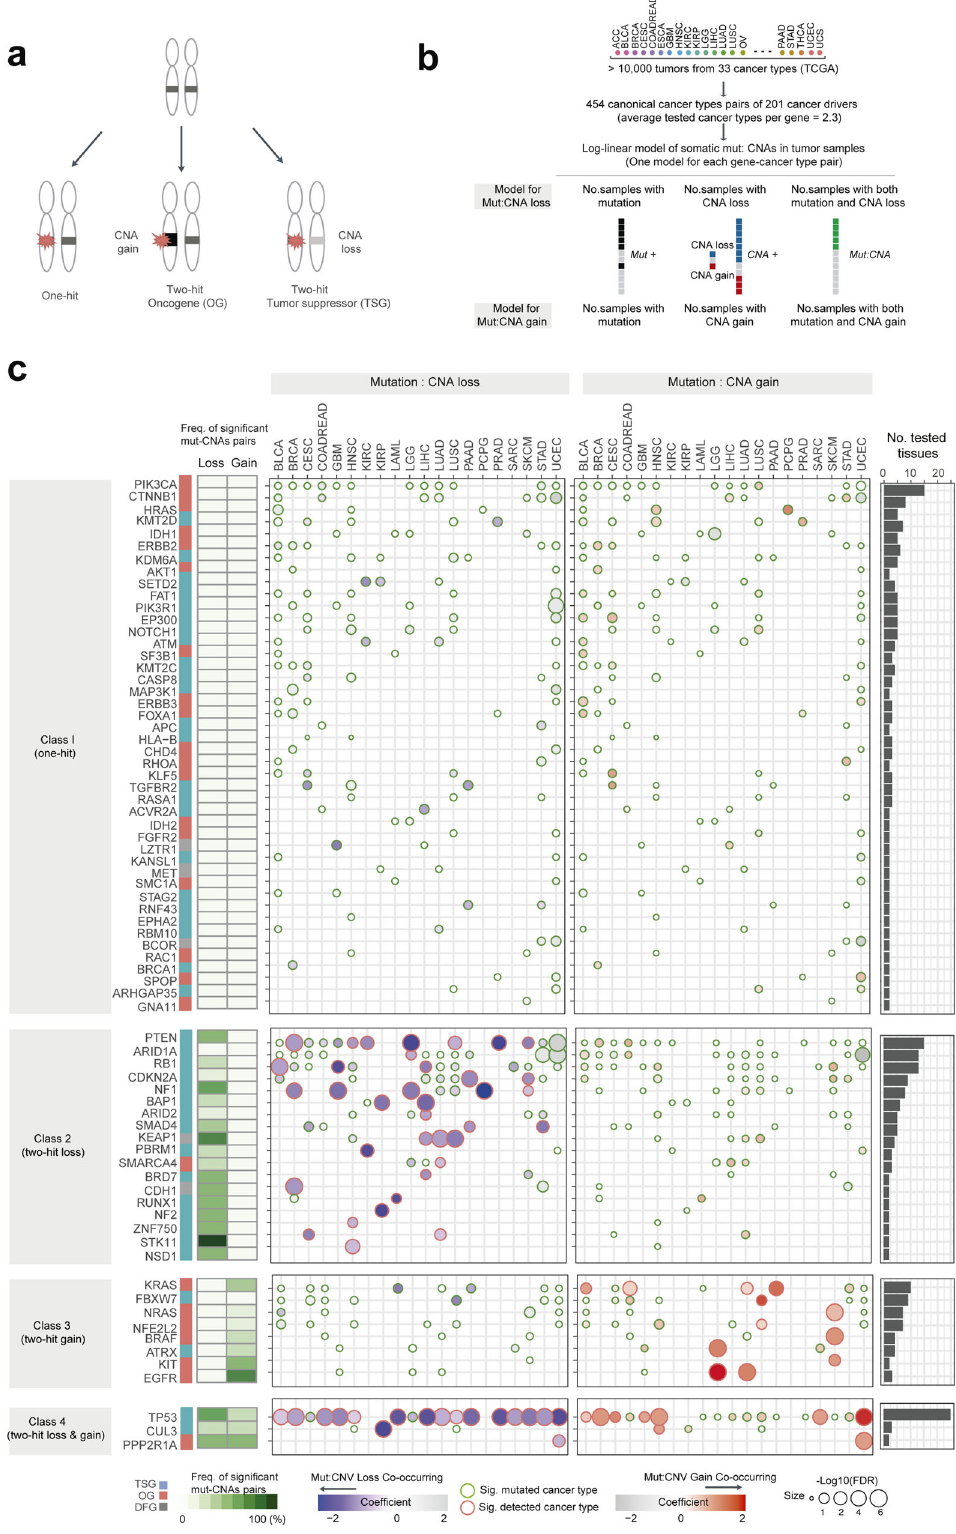
Fig. 1 Interactions between somatic mutations and CNAs in human tumors. a Classical one-hit and two-hit models. b Log-linear regression for identifying interactions between mutations and CNAs. c Interaction coef fi cient (i.e., effect size) and FDR-values in each cancer type for 73 cancer genes tested in at least two cancer types. Cancer types with >150 samples and at least 1 signi fi cant interaction are shown (FDR = 10%). The full data set is shown in Supplementary Fig. 3. Cancer-type abbreviations are listed in Supplementary Table 1. Source data underlying c are provided as a Source Data fi le.